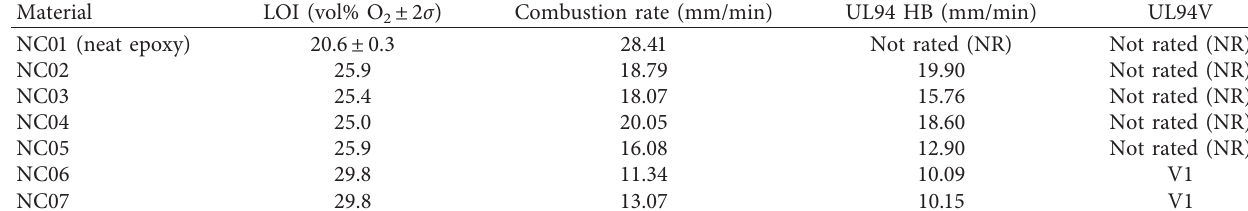
Table 6: Results for flammability tests (reaction to small flame), oxygen index (OI), and UL 94 for nanocomposites.